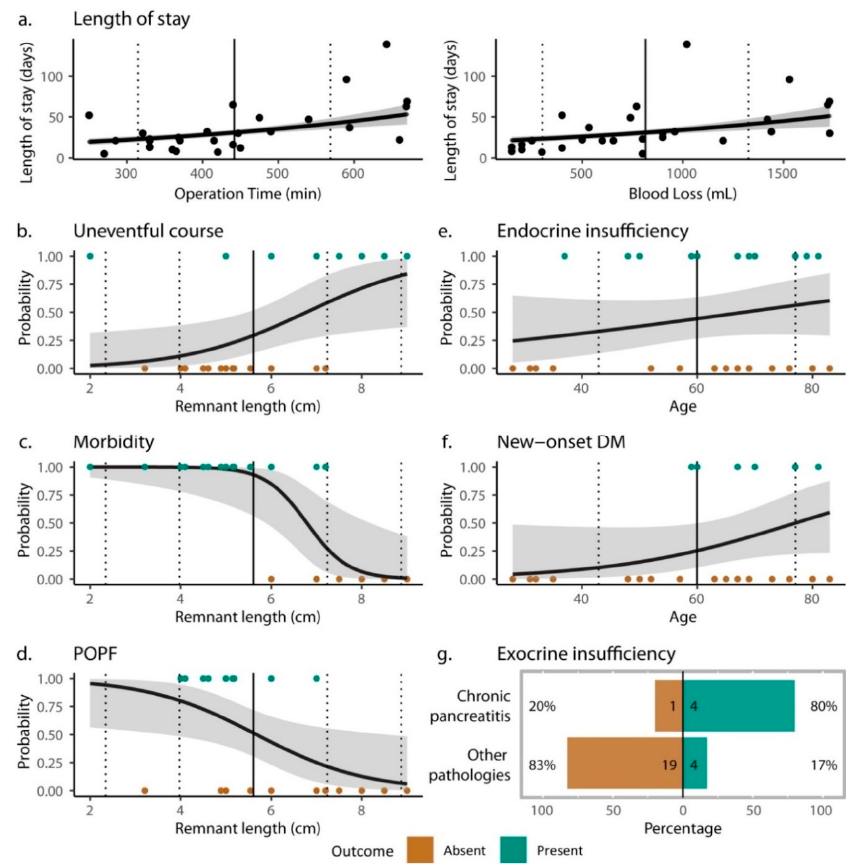
Figure 5. Summarized results for prognostic indicators of postoperative outcomes following MPP surgery: ( a ) length of stay by operation time and blood loss; ( b ) probability of uneventful postopera- tive course by remnant length; ( c ) probability of morbidity by remnant length; ( d ) probability of POPF by remnant length; ( e ) probability of endocrine insufficiency by age; ( f ) probability of new-onset diabetes mellitus by age; ( g ) frequency of exocrine insufficiency by chronic pancreatitis pathology. The bold curves represent the modelled probabilities for a ‘present’ response and shaded regions represent the 95% confidence interval; mean and standard deviation for the predictor variables are represented by solid and dotted lines, respectively; points represent observed outcomes; full results are available in Tables A5–A8. DM: diabetes mellitus. POPF: postoperative pancreatic